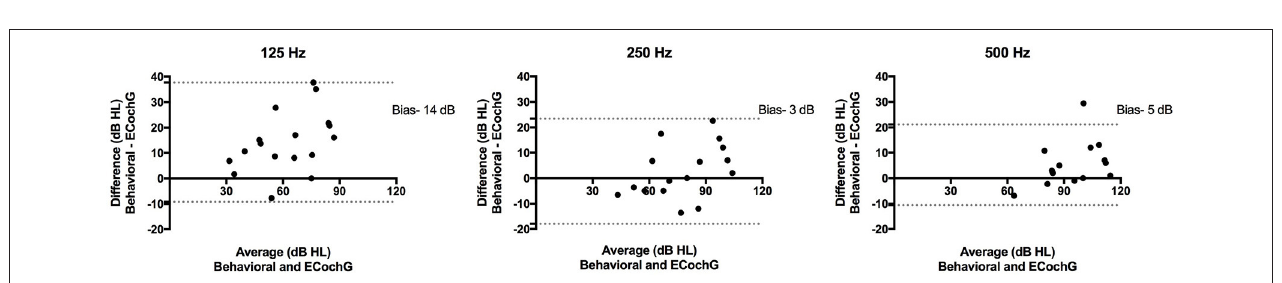
FIGURE 5 | Bland-Altman plots depict the average and difference between postoperative behavioral and ECochG thresholds at 125, 250, and 500Hz. The 95% limits of agreement are shown as two dotted lines. The biases, or average of the differences at each frequency, are reported.